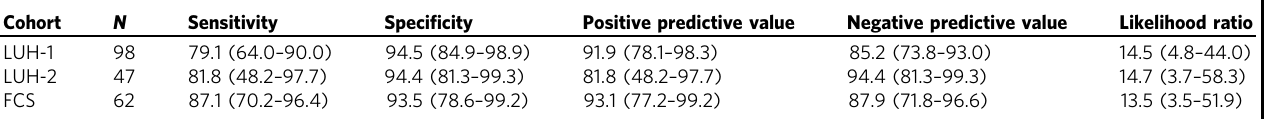
Table 3 Performance (sensitivity, speci fi city, positive and negative predictive values, and the likelihood ratio) of the combination of HGF and CXCL13 to further improve the discrimination between ICU and non-ICU COVID-19